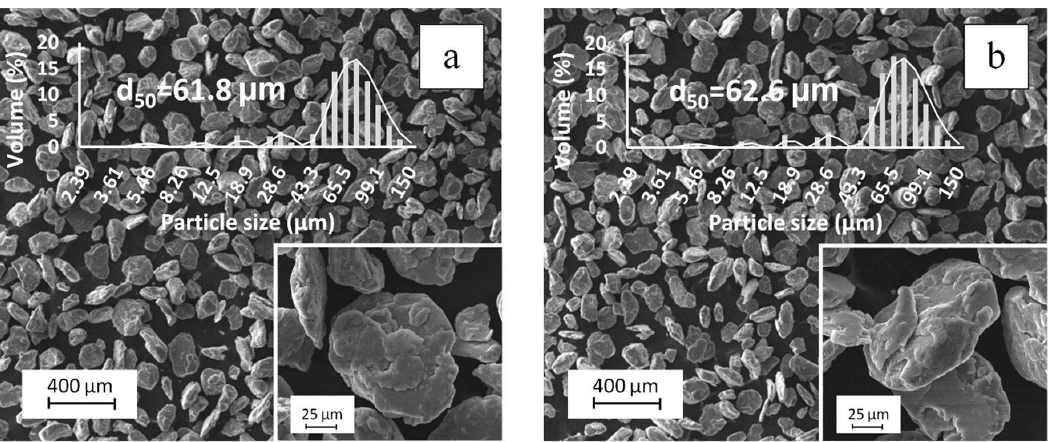
Figure 4. SEM images and dynamic light scattering (DLS) analysis of composite powders A_0.05CNT (a) and A_0.05TiC/CNT (b).